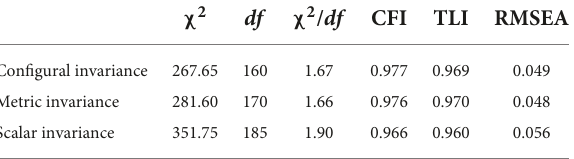
TABLE 4 Measurement invariance across genders. χ 2 df χ 2 /